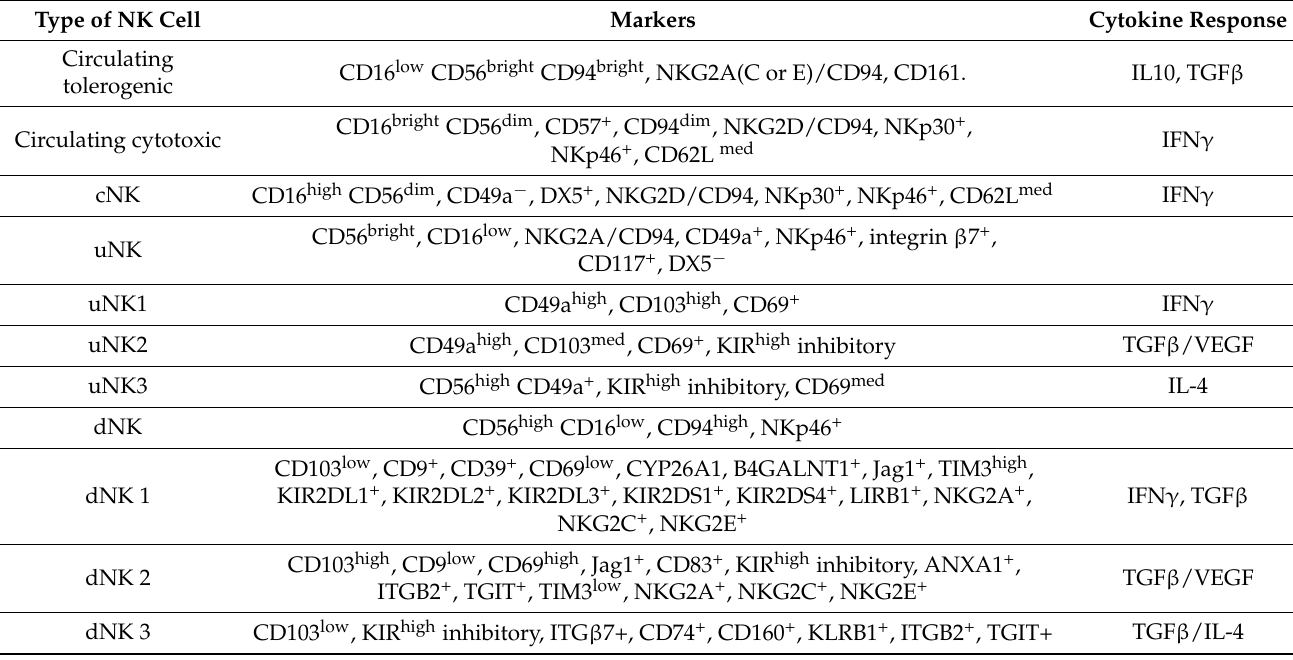
The table represents the described markers for different cell populations and the responses to cytokines. The term cNK are conventional NK cells, uNK are uterine resident NK cells, dNK are decidual NK cells. The acronym LIRB1 corresponds to Leukocyte